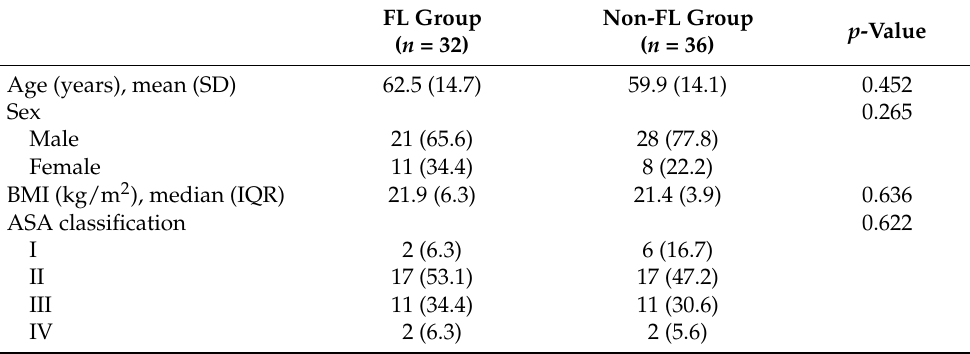
Table 1. Comparison of clinicopathologic characteristics.